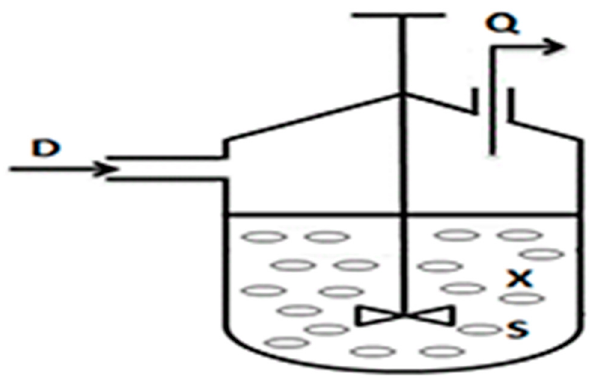
Figure 1. Bioreactor basic schematics .